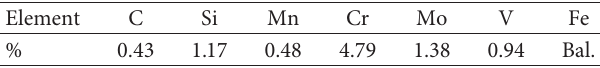
Table 1: Chemical composition of H13 steel sample used in the experiment (weight). Element